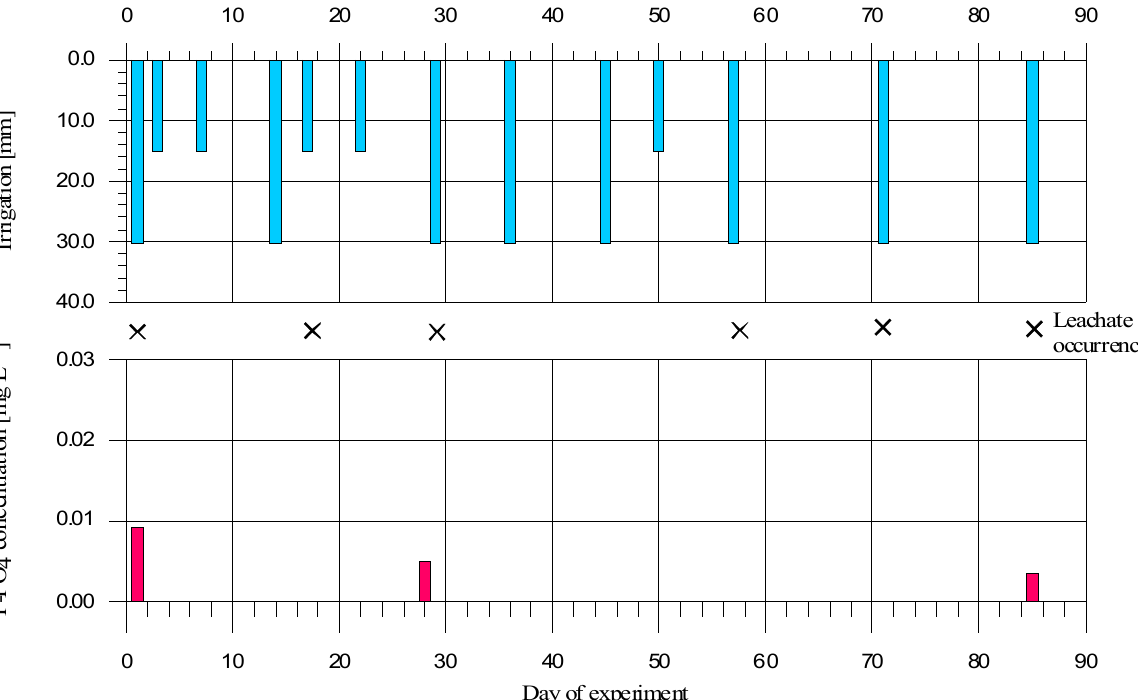
concentration in leachate from 4